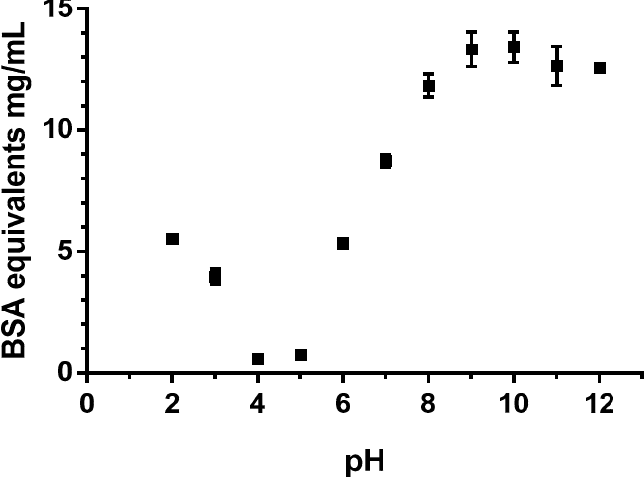
Figure 1. Quinoa protein solubility at different pH values. Obtained from aqueous suspensions of defatted flour (1:10 w / v ) maintained at a constant pH (NaOH or HCl) for 10 min at 30 °C and 100 rpm. n = 2. Values (mean ± SD) are expressed as bovine serum album equivalents